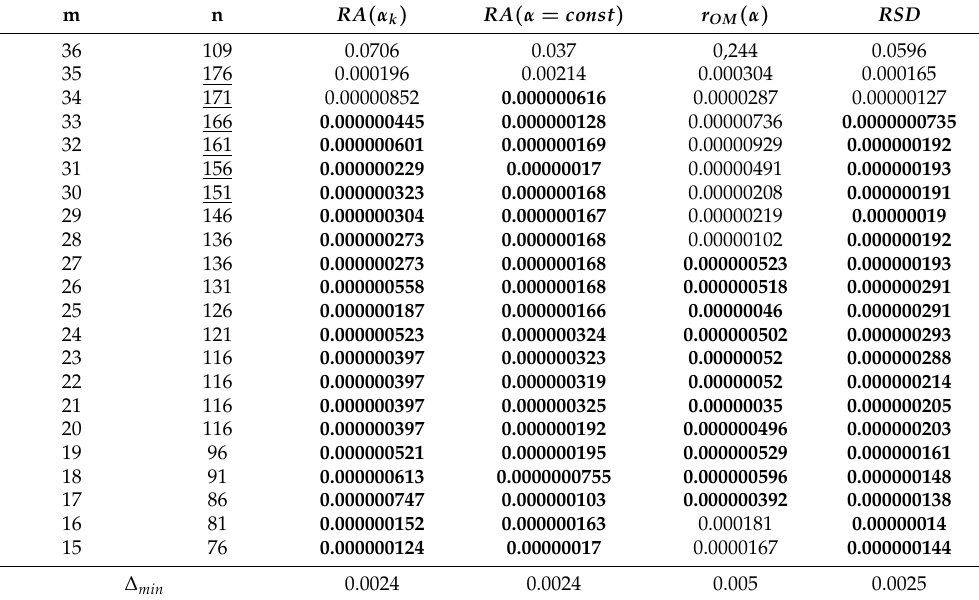
Table 11. Results of function f 7 ( x ) approximation by RBF ANN with a regularizer R γ ( w ) , m 0 = 36, N 0 = 150, α = 10 − 7 , S ( DT 10.000, f ) . The values with the limiting order of accuracy are given in